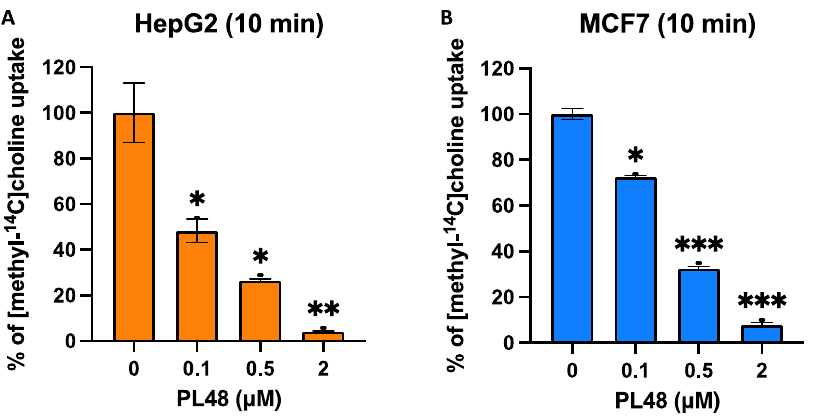
Figure 7. Effects of PL48 on choline uptake in HepG2 ( A ) and MCF7 ( B ) cancer cell lines. Choline uptake was assayed in cells treated for 10 min with increasing concentrations of inhibitor. Data represent the mean ± SEM of two independent experiments conducted in triplicate. Results are normalised to their respective controls. * p < 0.05, ** p < 0.001, *** p < 0.0001.